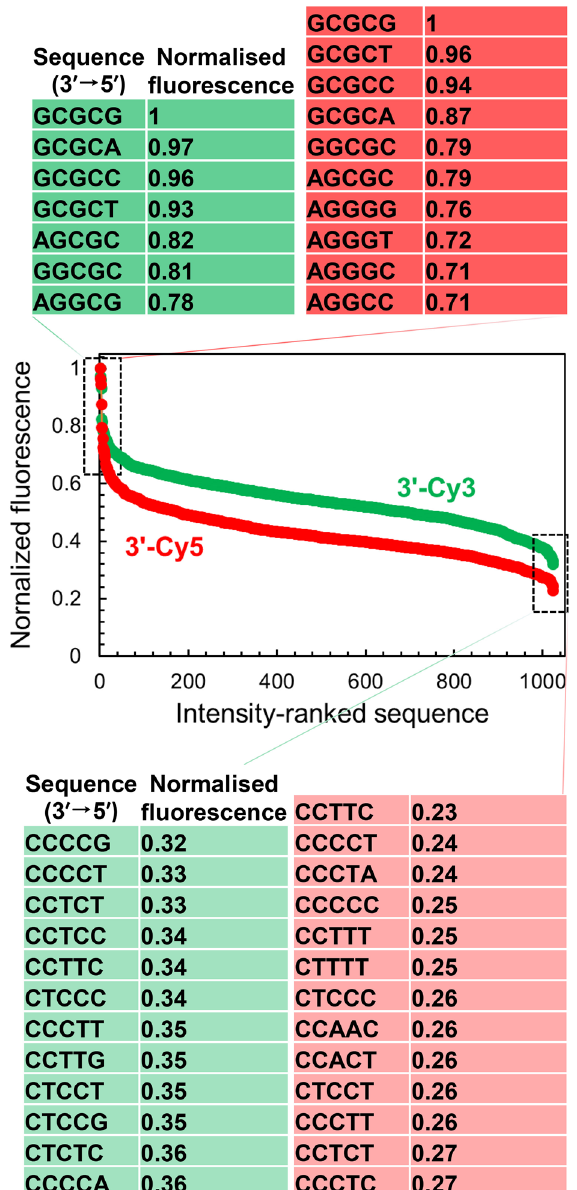
Figure 2. Variations in Cy3 and Cy5 fluorescence intensity as a function of sequence identity in 3 ʹ -labeled single-stranded DNA oligonucleotides. The relative fluorescence intensity of Cy3 and Cy5-labeled 5mers was ranked from most to least intense (highest recorded fluorescence and its corresponding 5mer = 1). For Cy3 fluorescence the intensity falls by ≈ 65% and Cy5 by ≈ 73%. A list of the brightest and darkest fluorescent 5mers is shown to the top and bottom part of the panel,